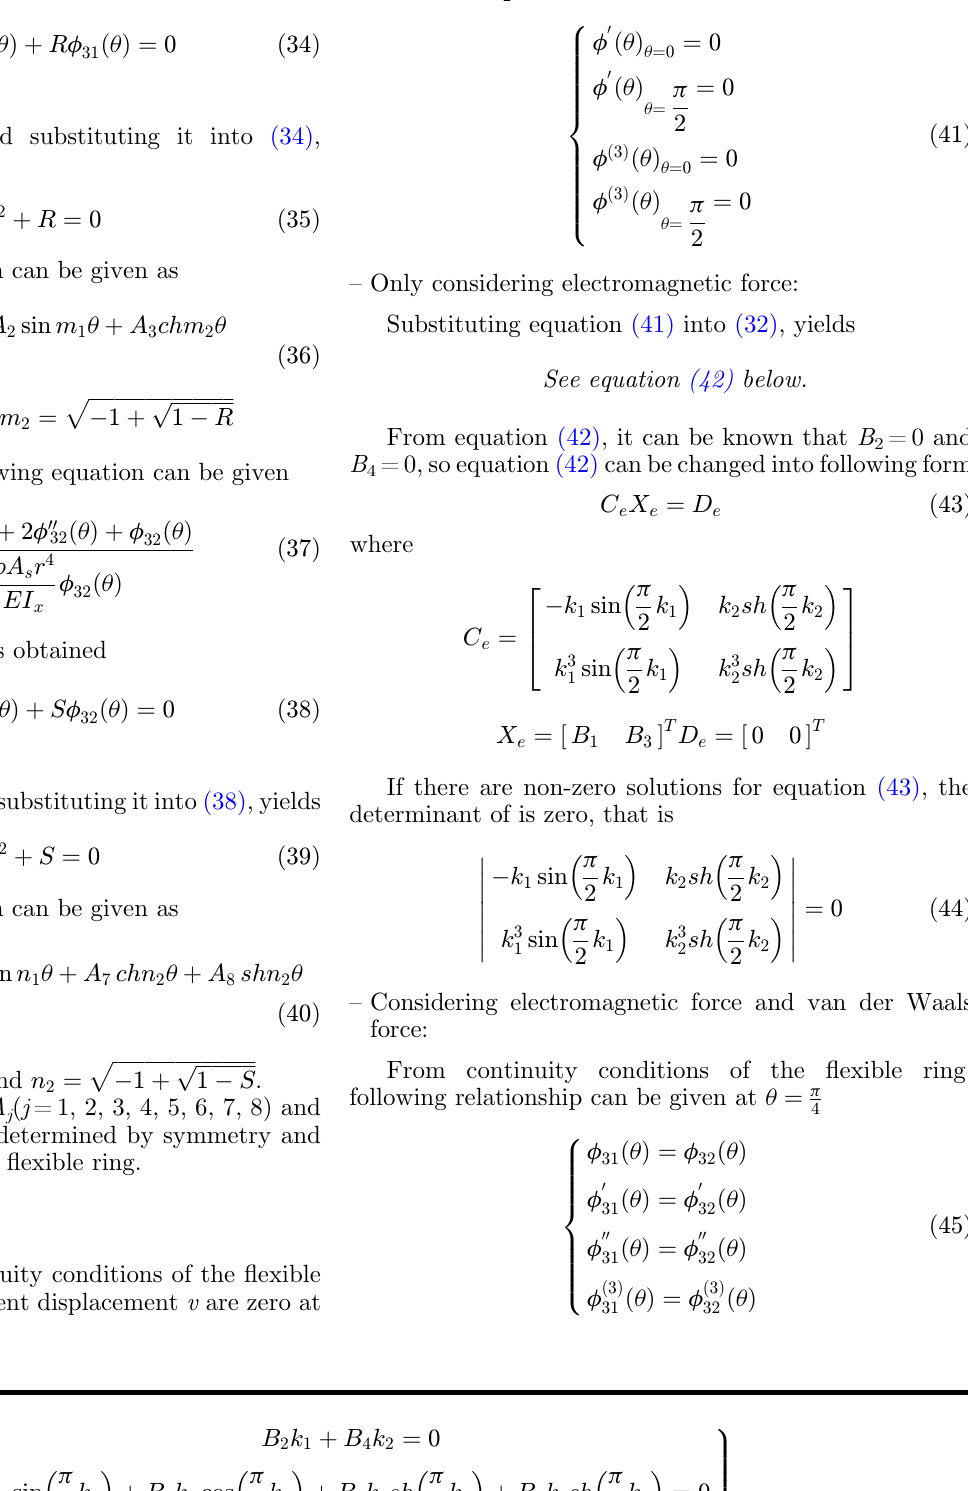
ffiffiffiffiffiffiffiffiffiffiffiffiffiffiffiffiffiffiffiffiffiffiffiffiffiffiffiffi (cid:1) 1 þ